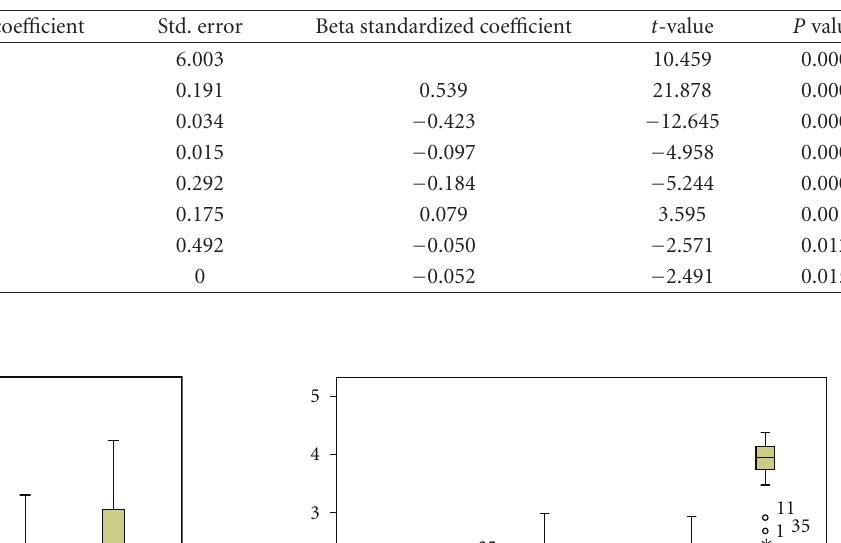
Table 5: Estimates of coe ffi cient of the model (dry season) of parameters in mg/L except for temperature, conductivity, and pH.